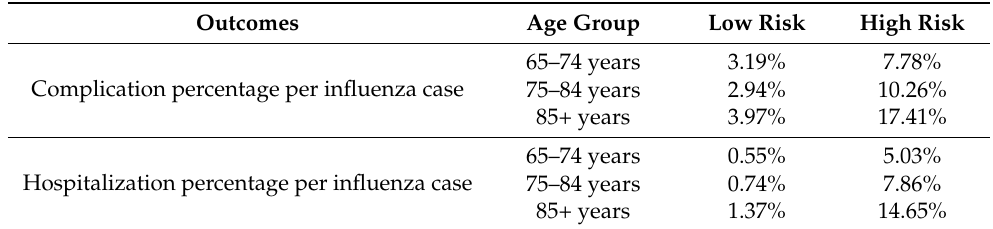
Table 1. Complication and hospitalization percentages, stratified by age group and comorbidity risk level [13].